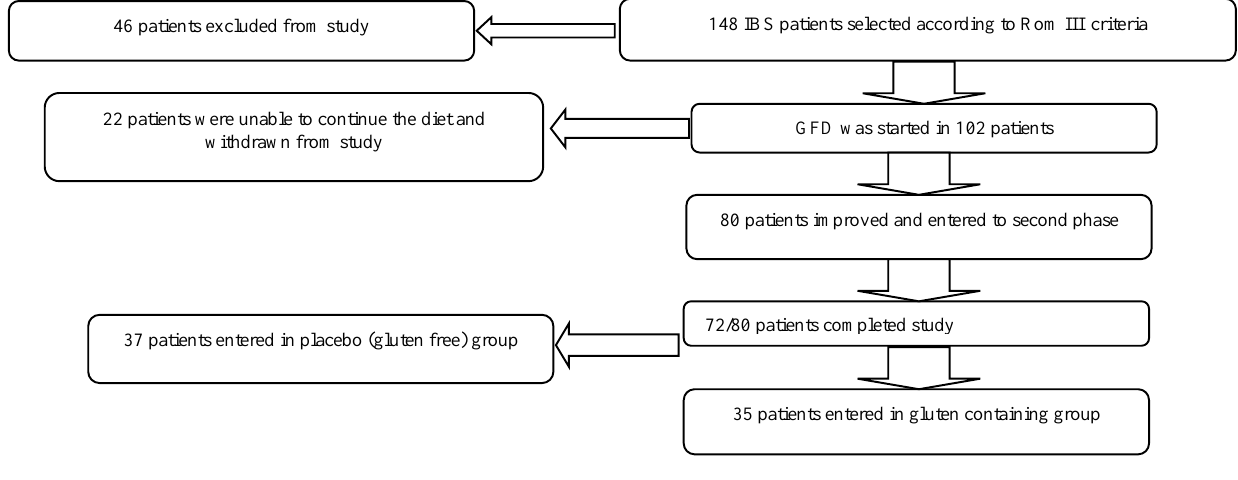
Figure 1. Recruitment pathway and reasons for screen failure and withdrawals